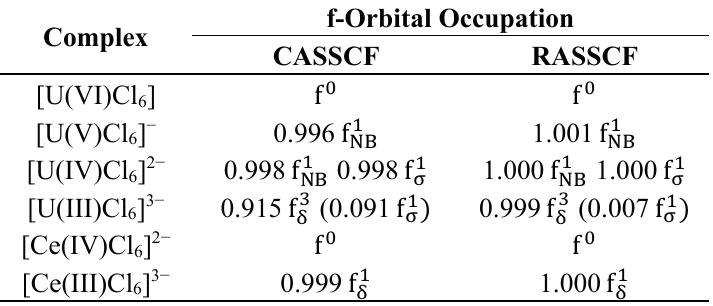
Table 2. f-Orbital occupations for each complex considered in this study, calculated at the Complete/Restricted Active Space Self-Consistent Field (CAS/RASSCF) level of